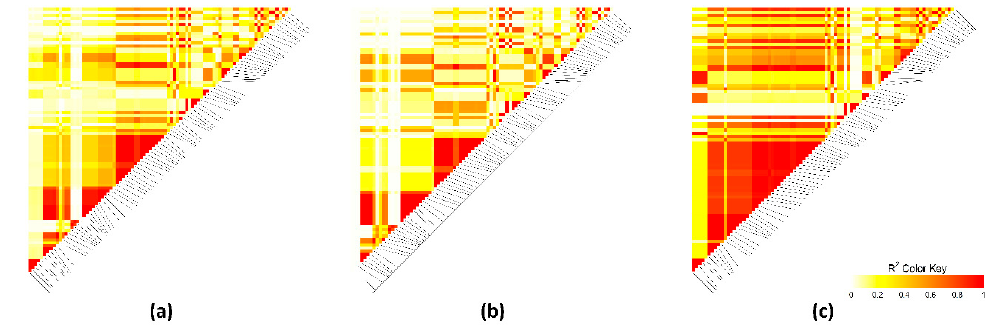
Figure 5. Linkage disequilibrium plot at 148.5–150.2 Mb on chromosome 3. Colors from white to red indicate r 2 value. ( a ) All lines. ( b ) High-IMF line. ( c ) Low-IMF line.